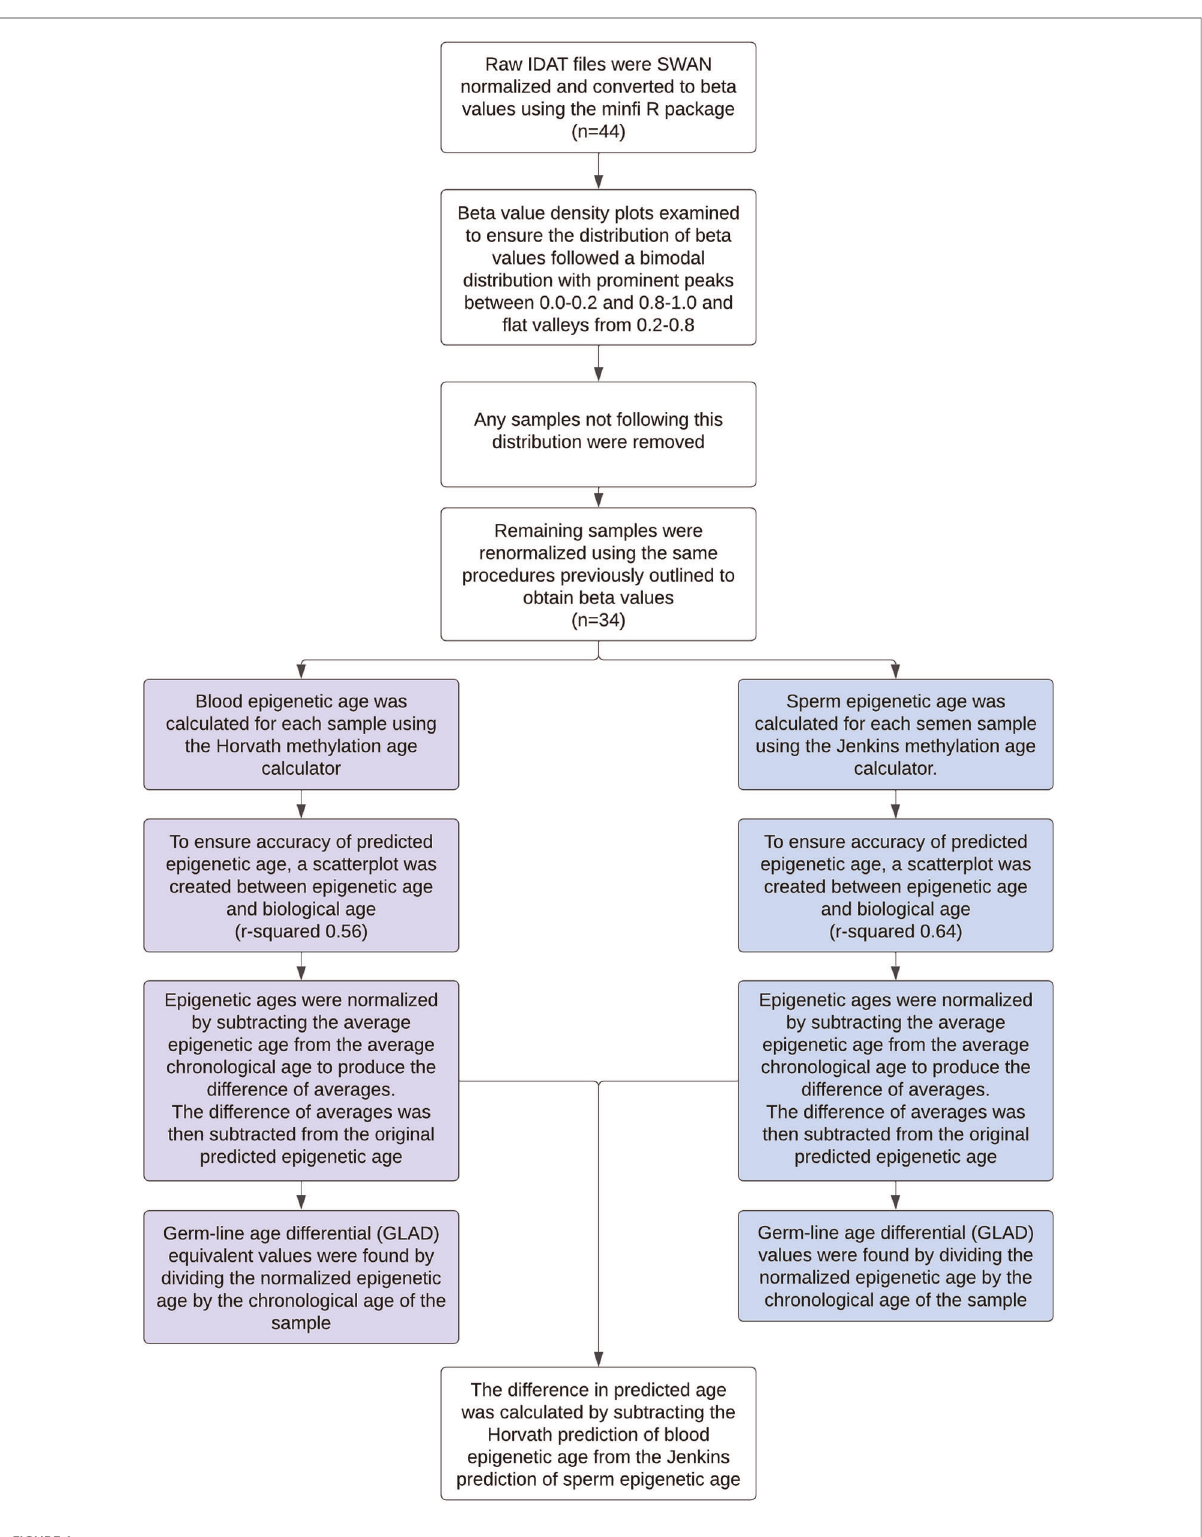
FIGURE 1 Flow chart detailing the data preprocessing and statistical analyses performed on each